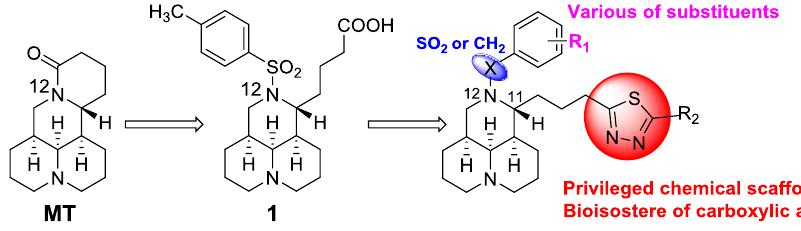
Figure 1. Chemical structures of matrine and the lead compound 1 , and structure modification strategy.